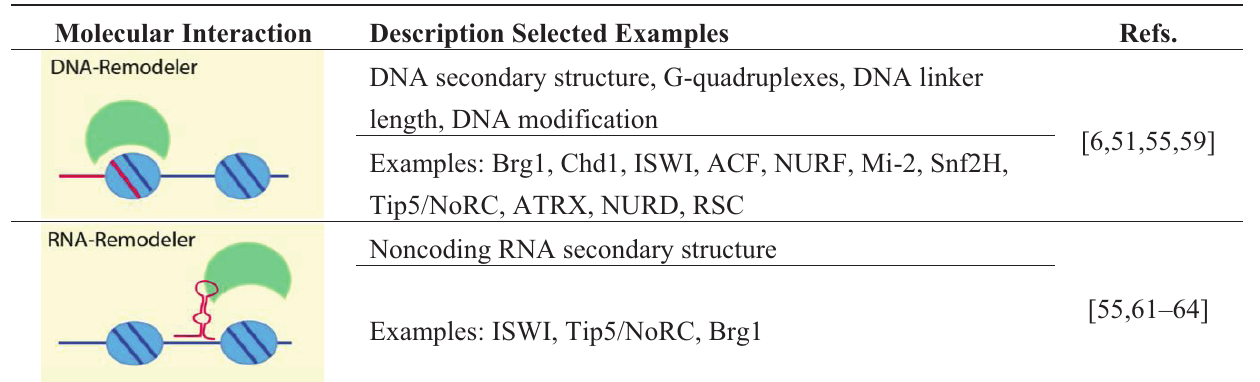
Table 1. Targeting signals recognized by chromatin